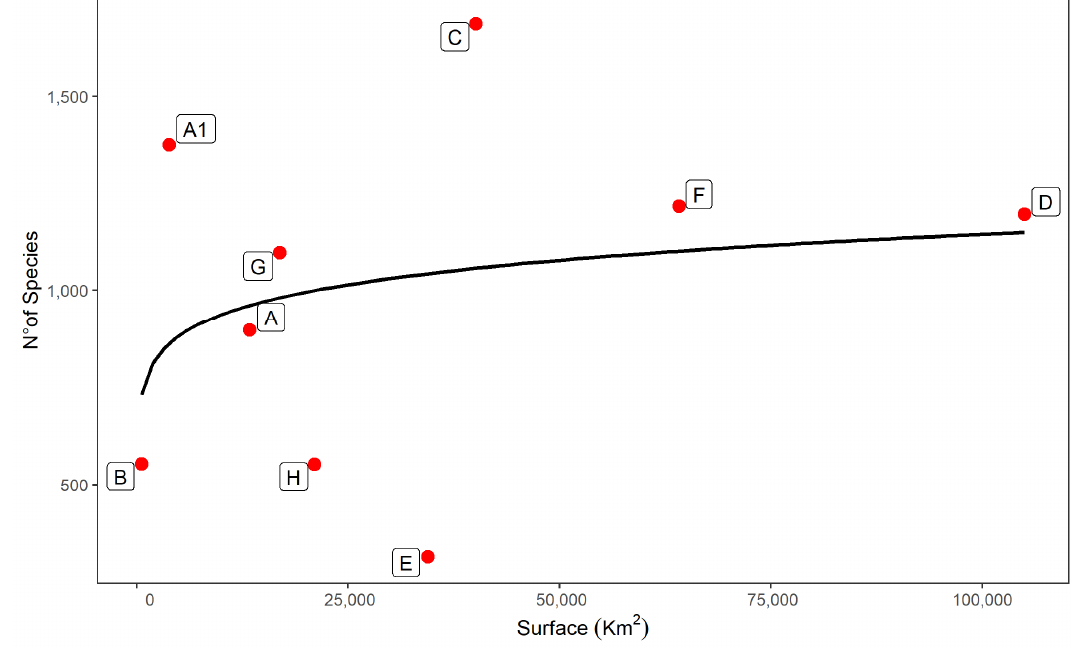
Figure 8. Relationship between number of taxa and total surface (SAR: species-area relationship) built by following the Arrhenius model (S = cA z ). The surface is expressed in square km. Letters in capital are the 9 ecoregions: Alpine (A), Subalpine (A1), Oromediterranean (B), Montane (C), Dry Submediterranean (D), Padanian (E), Humid Submediterranean (F), Humid Mediterranean (G), Dry Mediterranean (H).